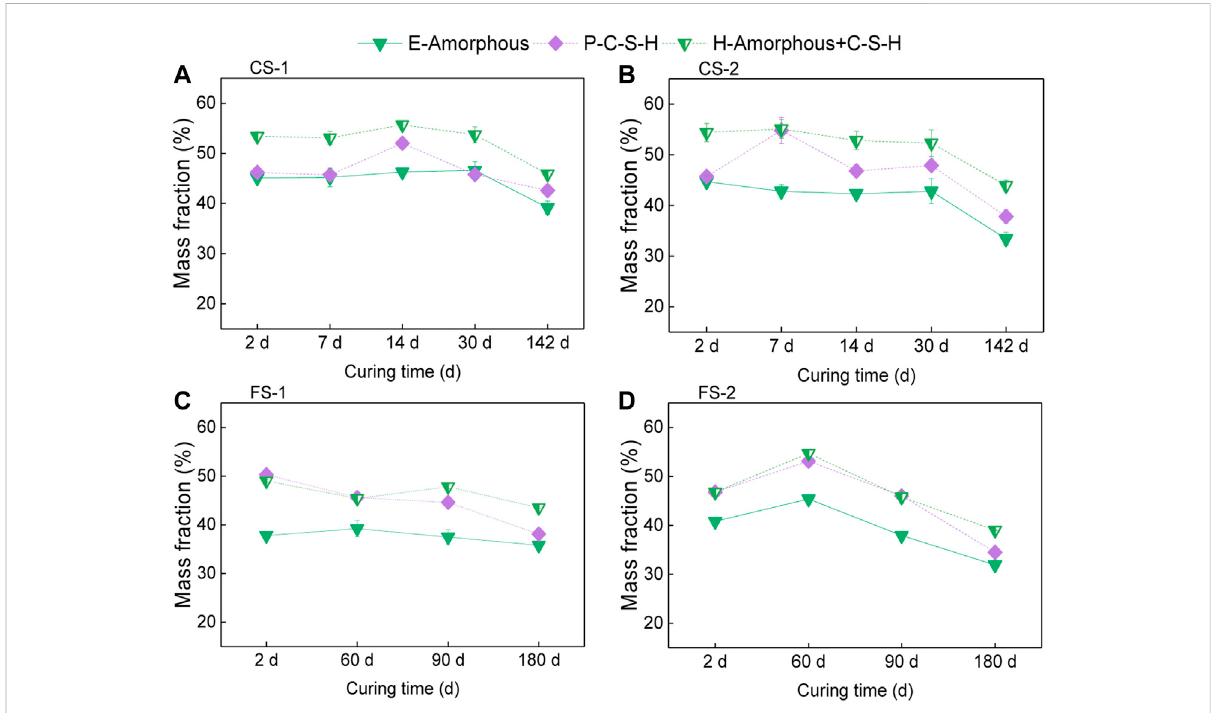
FIGURE 10 Comparisonoftheamorphousphasecontentobtainedbydifferentmethods.(E:theexternalstandardmethod;P:thePONKCSmethods;H:the hybrid method). (A) slurry CS-1 (B) slurry CS-2 (C) slurry FS-1 (D) slurry